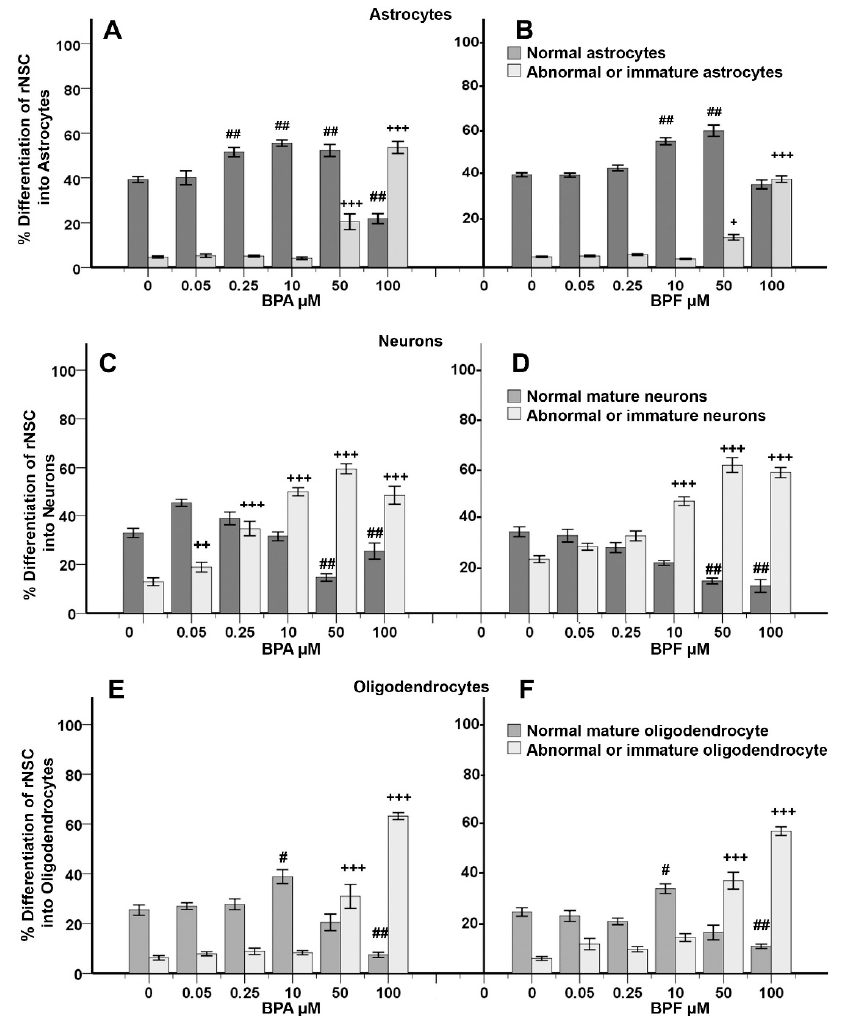
Figure 5. Effects of different concentrations of Bisphenol A (BPA) or Bisphenol F (BPF) treated for seven days, on the %differentiation of rNSC in the relevant cell-specific directed-differentiation medium. The %differentiation was enumerated as an index of the differentiation process of rNSCs into astrocytes ( A , B ), neurons ( C , D ), and oligodendrocytes ( E , F ), respectively. Control groups cells were differentiated into relevant cell types in the absence of BPA or BPF (0 µM). Differentiated astrocytes neurons and oligodendrocytes were visualized with cell-specific protein-markers GFAP, MAP2, and mGalc, respectively. Fluorescent, DAPI, and phase-contrast superimposed images were used for the quantification of the normal mature cell, and immature or abnormal cell types of each cell category. Each data point represents mean ± SE; + p < 0.05, ++, # p < 0.01, +++, ## p < 0.001 compared with the relevant controls.